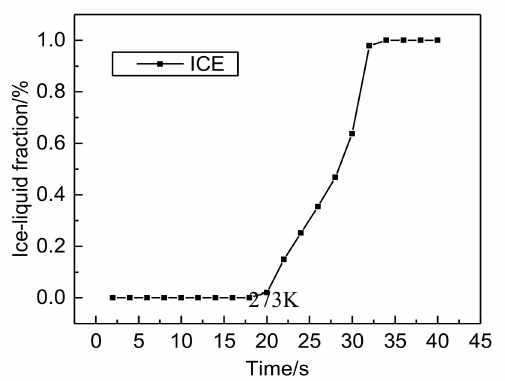
Figure 7. The liquid fraction distribution of the ICE layer in the PEMFC stack.